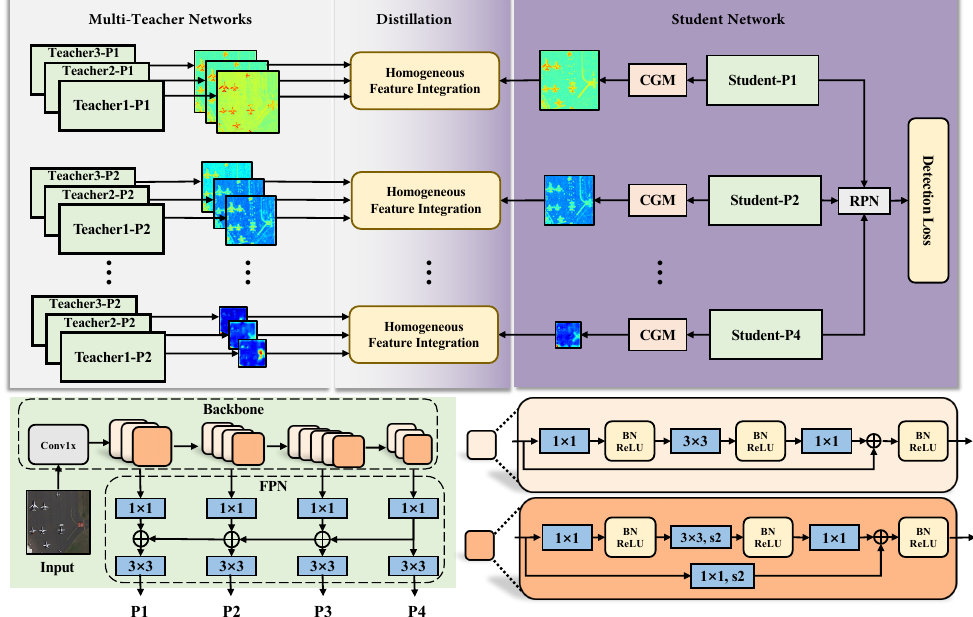
Figure 2. The overall framework of context-aware dense feature